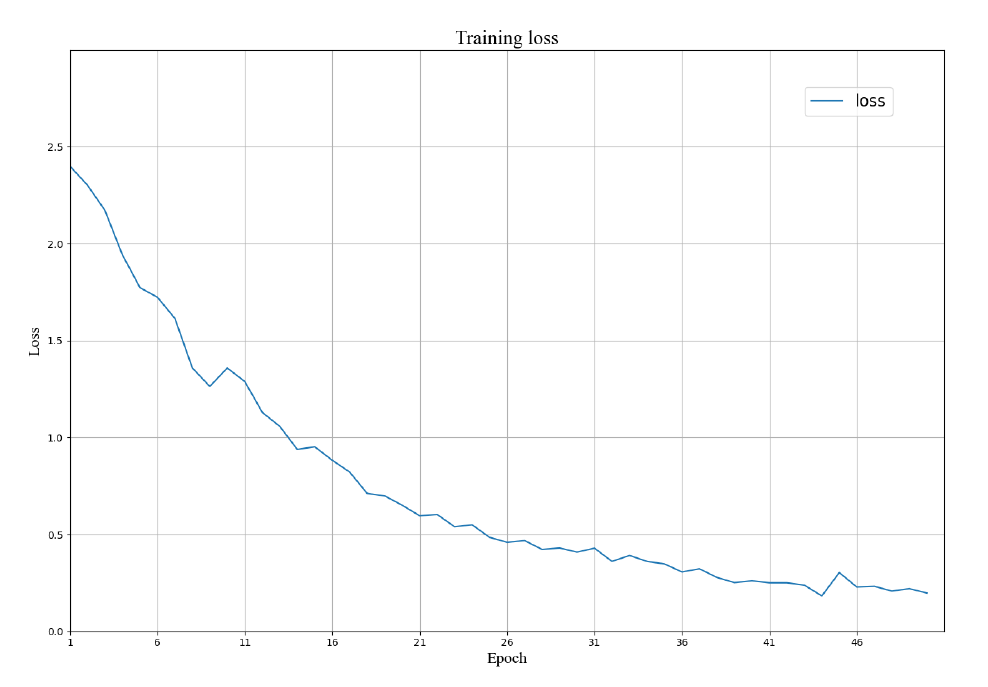
Figure 7. The picture shows the loss reduction of the training